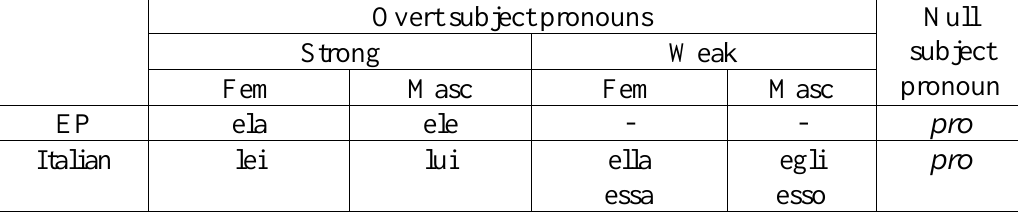
Table 1. Third person singular subject pronouns in EP and